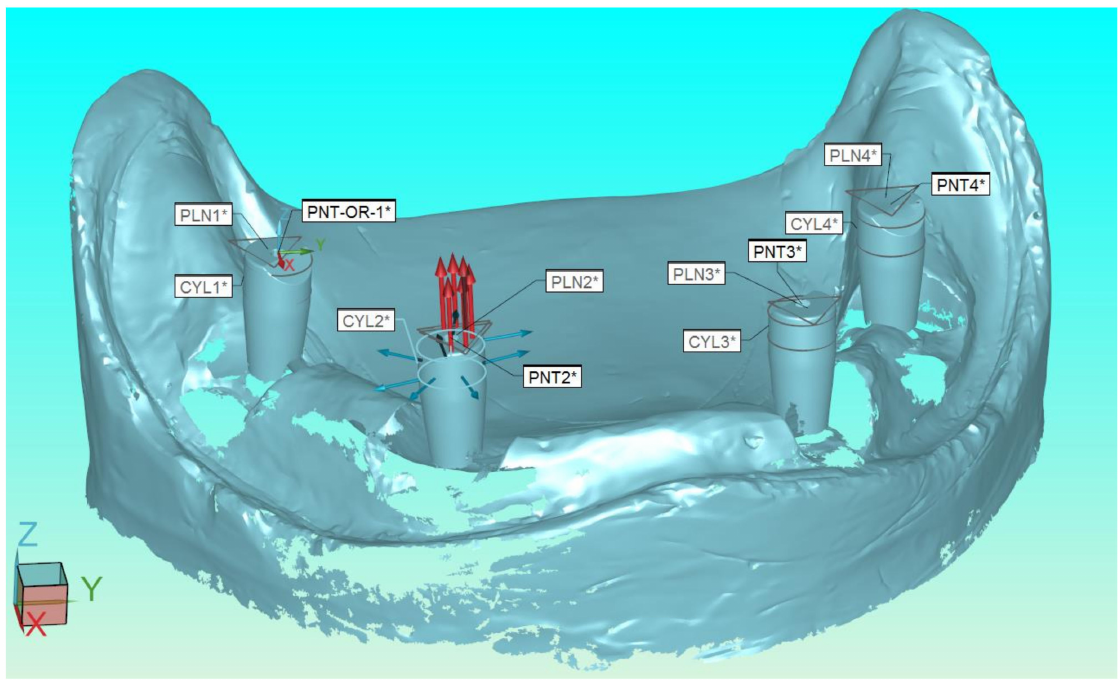
Figure 1. Contact points collected on the outer cylindrical surface (8 points marked in blue) and on top planar surface of the cylindrical element (6 points marked in red) for each implant in PC-DMIS measurement